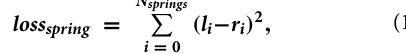
and ( u , v ± 2 k ) and ( u ± 2 k , v ) (“bend” springs), insofar